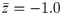
Results of k-means method.(a) Dataset classified into two clusters. Blue dots represent the cluster of reflection molecules, and orange dots represent the cluster of condensation/evaporation molecules. Inset shows that the two clusters are divided by a dotted line at approximately zreach = −1.0. (b) Percentages of excluded molecules from each cluster in the case where the liquid boundary was set at z¯=-1.0.